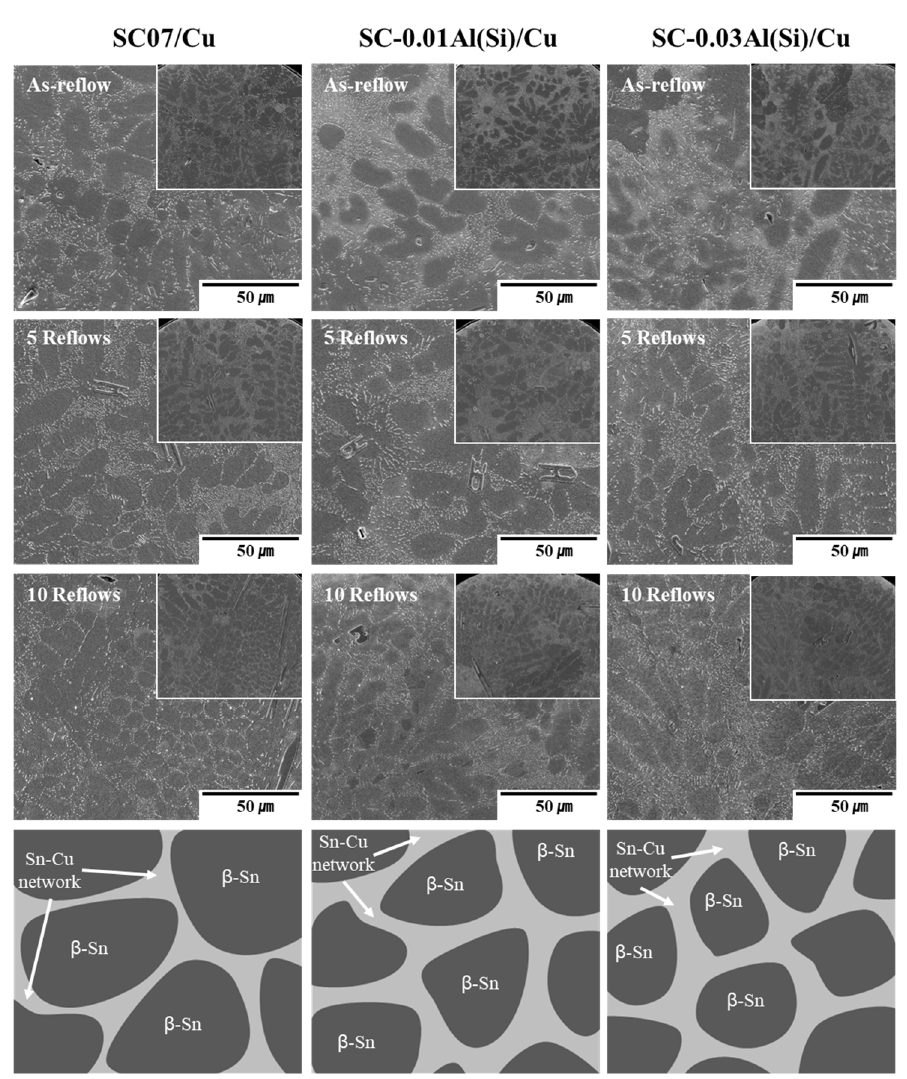
Figure 9. Secondary electron SEM images showing the microstructures of the solder balls under various reflows.